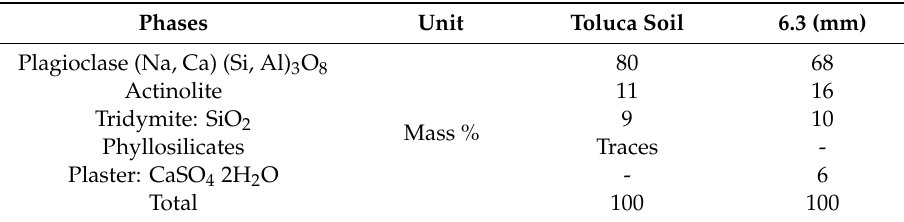
Table 11. X-ray di ff raction analysis of excavation material and construction waste.